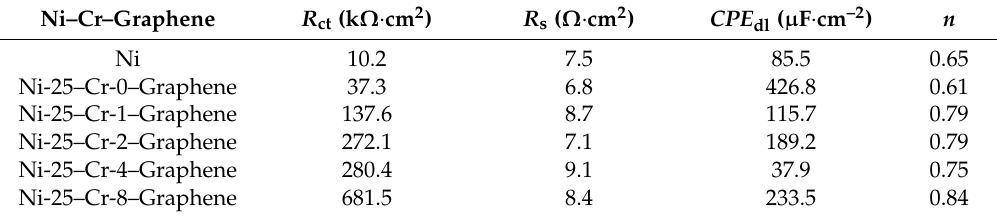
Figure 15. Equivalent circuit of the Ni–Cr–graphene coatings in 3.5% NaCl solution. Table 3. Corrosion factors from equivalent circuits of the Ni–Cr–graphene coatings.